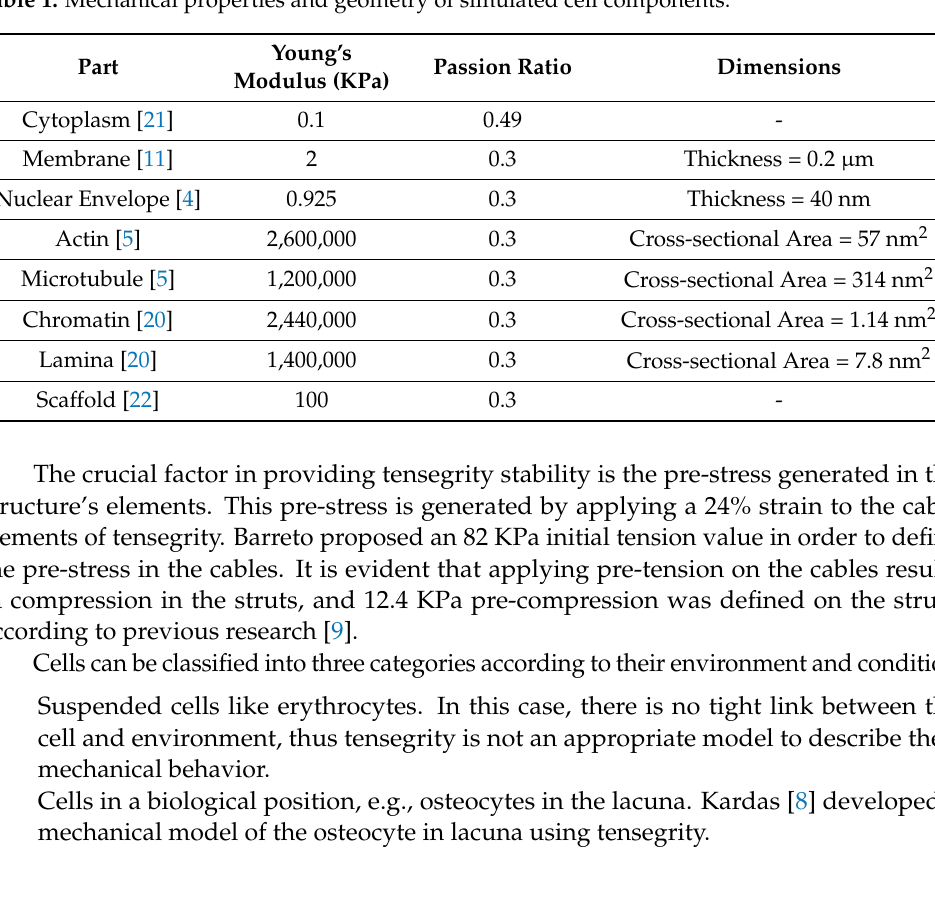
Table 1. Mechanical properties and geometry of simulated cell